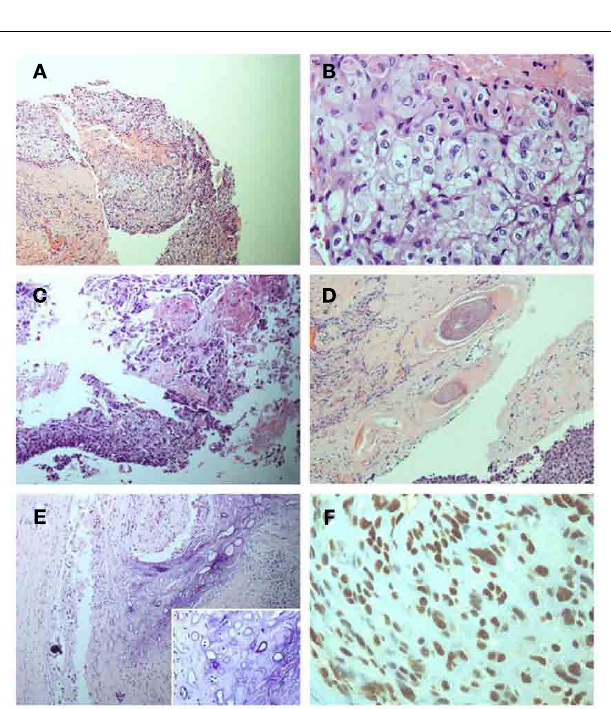
FIGURE 5 | (A) Gross photo of the base of the brain showing “icing-like” leptomeningeal thickening over the midbrain, pons, and medulla (circle). (B) Gross photo of the spinal cord with similar leptomeningeal, “icing-like” thickening over the surface of the spinal cord.